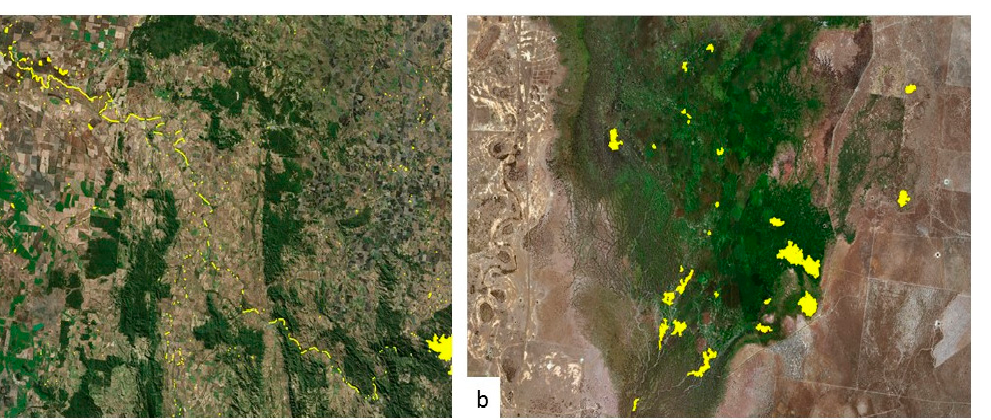
Figure 11. Limitations of DEA Waterbodies associated with mixed water and vegetation targets. This results in ( a ) discontinuity within some river reaches, and ( b ) an under representation of waterbodies within wetlands.